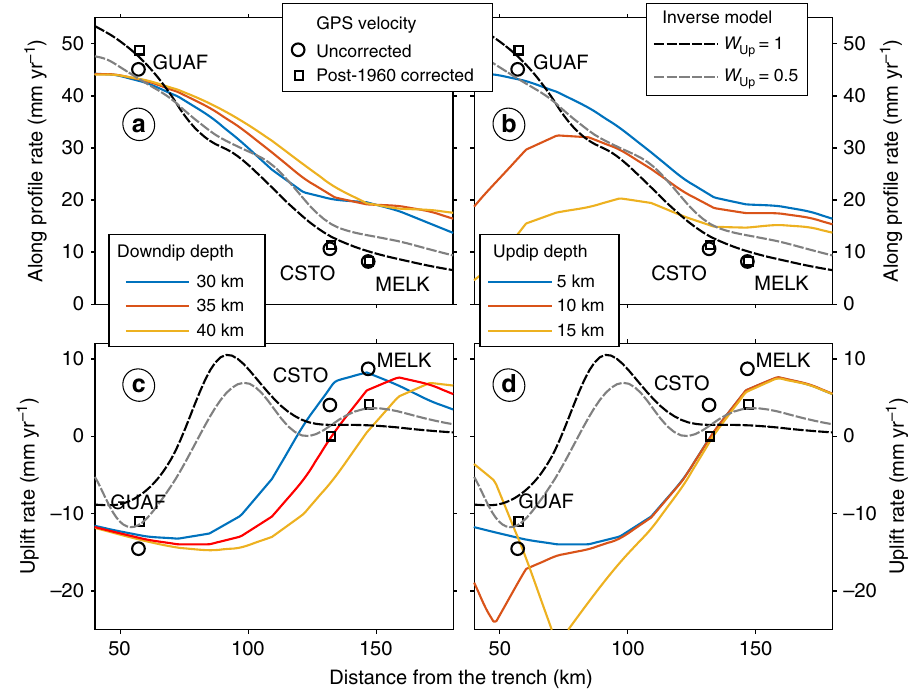
Fig. 4 Continuous GPS velocities and back-slip forward and inverse models across the south Chile forearc. Velocities projected along the pro fi le line of Fig. 1. Stippled lines in all panels show inverse model results (Methods). W up weight of vertical GPS velocities. a , c Forward model results for variable downdip locking depths, using an updip depth of 5 km. Variations in the downdip depth mostly in fl uence inland GPS sites CSTO and MELK (location in Fig. 1). Best- fi tting depths are consistent with full plate locking down to the intersection of the continental Moho with the slab. b , d Model results for variable updip locking depths, using a 30-km downdip depth. Note that most variability is in the horizontal component. Shallow locking is required to model the rapid inland velocity at site GUAF. Time series and trajectory models of daily GPS positions and post-seismic model time series in Supplementary Figs. 10 and 11, across the inland sector. For the purpose of our study, both